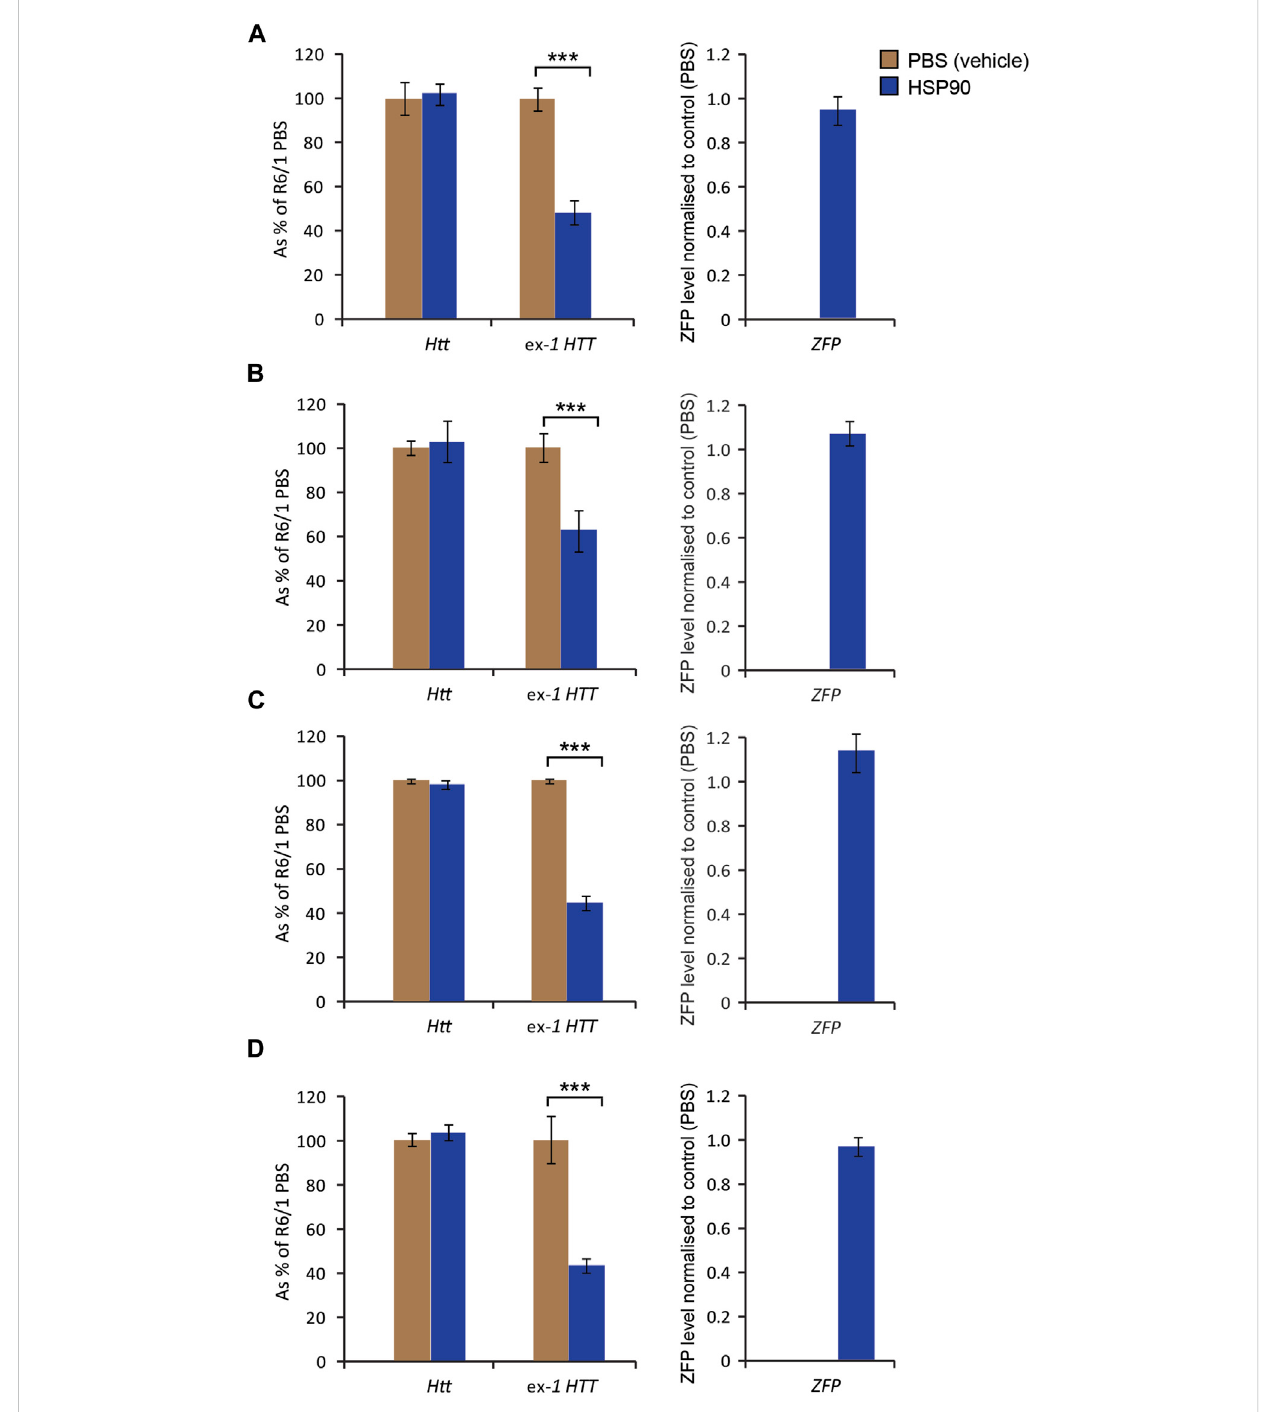
FIGURE 3 Effects of bilateral intraventricular injection of AAV expressing mZF-KRAB under the HSP90 promoter in speci fi c brain regions 6 weeks post an injection. Unchanged expression WT HTT transcripts, as well the repression of mutant Huntingtin mut-Exon1, by targeted zinc fi nger expression. mZF- KRAB (ZFP) transcript levels are from dissected brain regions of the R6/1 mice, treated with either AAV2/9 (carrying mZF-KRAB under the HSP90 promoter)orPBS(control).Thespeci fi cbrainregionsare: (A) cortex, (B) cerebellum, (C) striatum, (D) hippocampus.Alltranscriptlevels were normalized to three housekeeping genes see Supplementary Figure S3. Error bars are S.E.M ( n = 4). *** p <